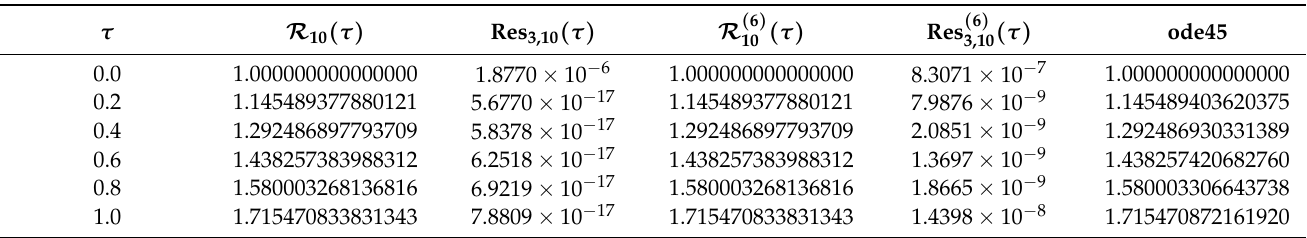
Table 6. The comparison of numerical results for in Test Case 2.